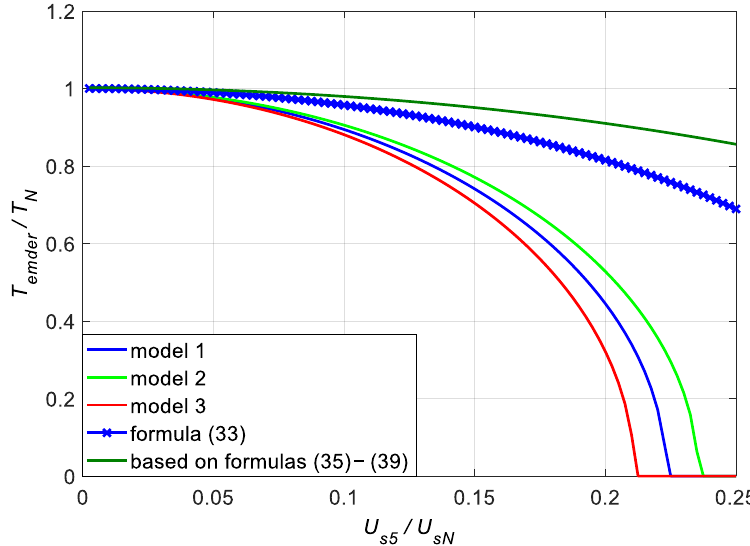
Figure 3. The sum of rotor load power losses from higher harmonics (i.e., 5th only) and admissible power losses in the rotor from the fundamental harmonic, as a function of the RMS value of the 5th harmonic of the supply voltage. Blue line — model 1, green — model 2, red — model 3, blue line with x symbol — based on Formulas (29) – (32).